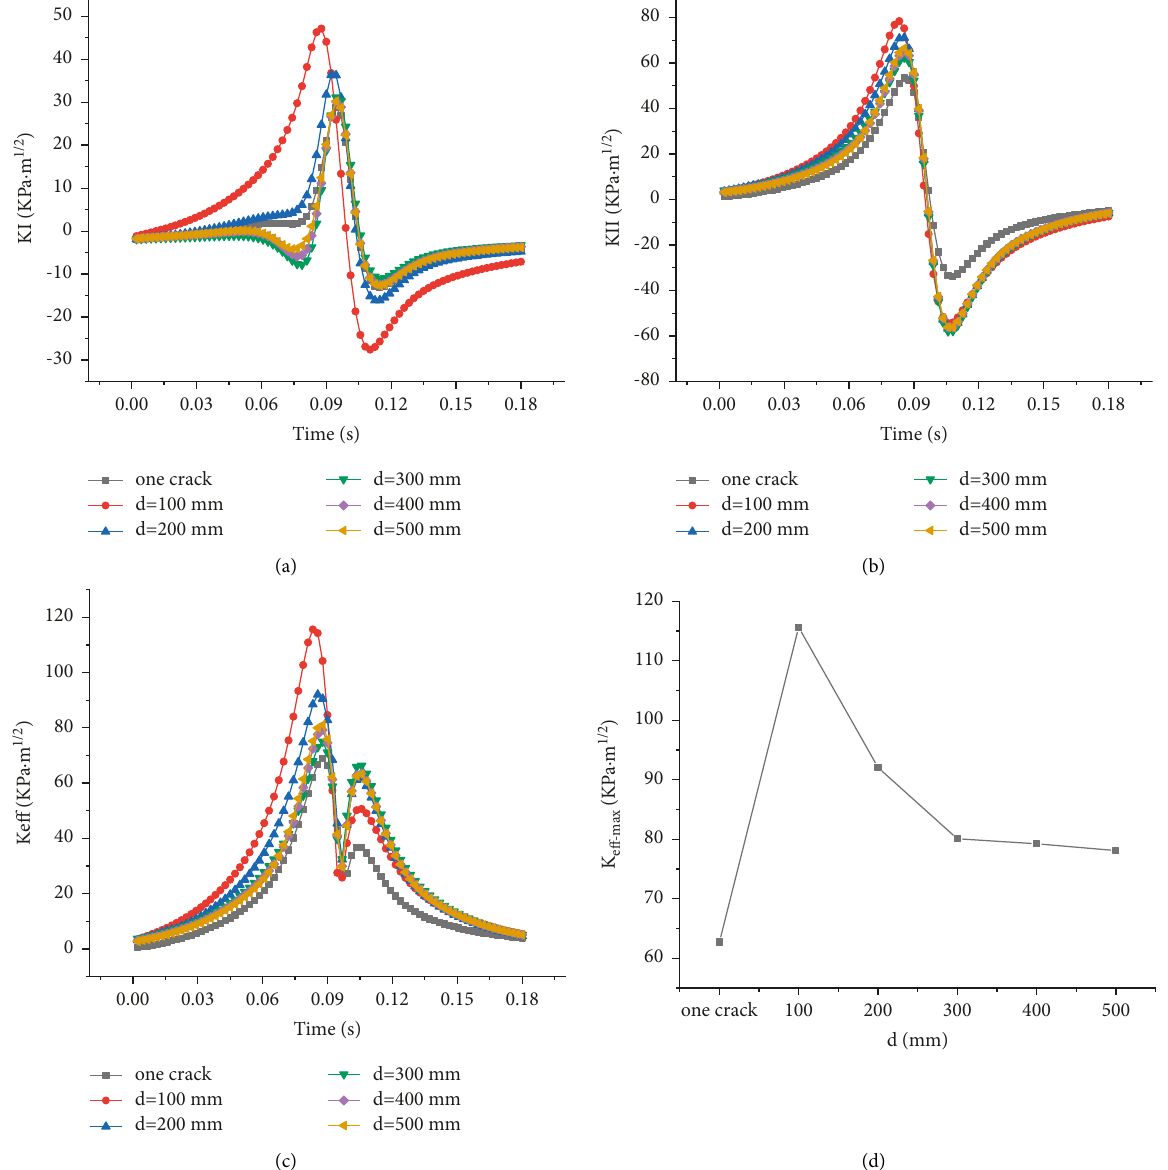
Figure 4: The SIF of the penetrating crack time history curve with various spacings. (a) KI; (b) KII; (c) Keff; (d)